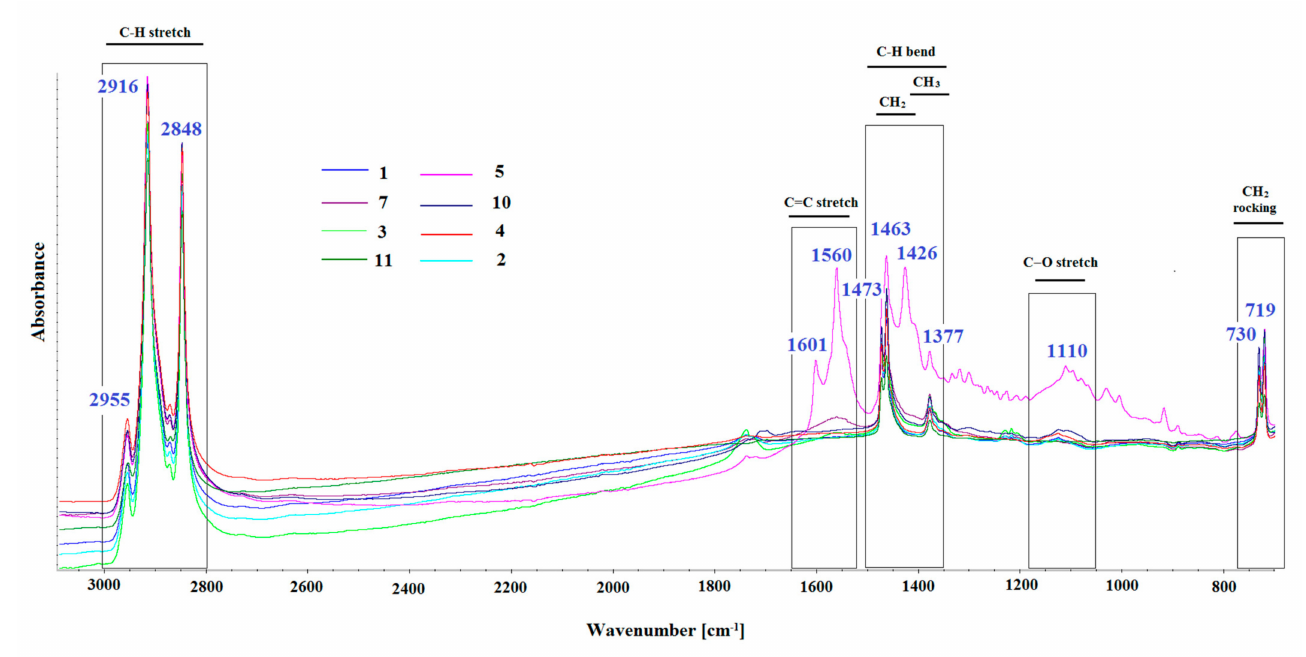
Figure 3. FTIR spectra of curing compound for concrete for samples no. 1–5, 7 and